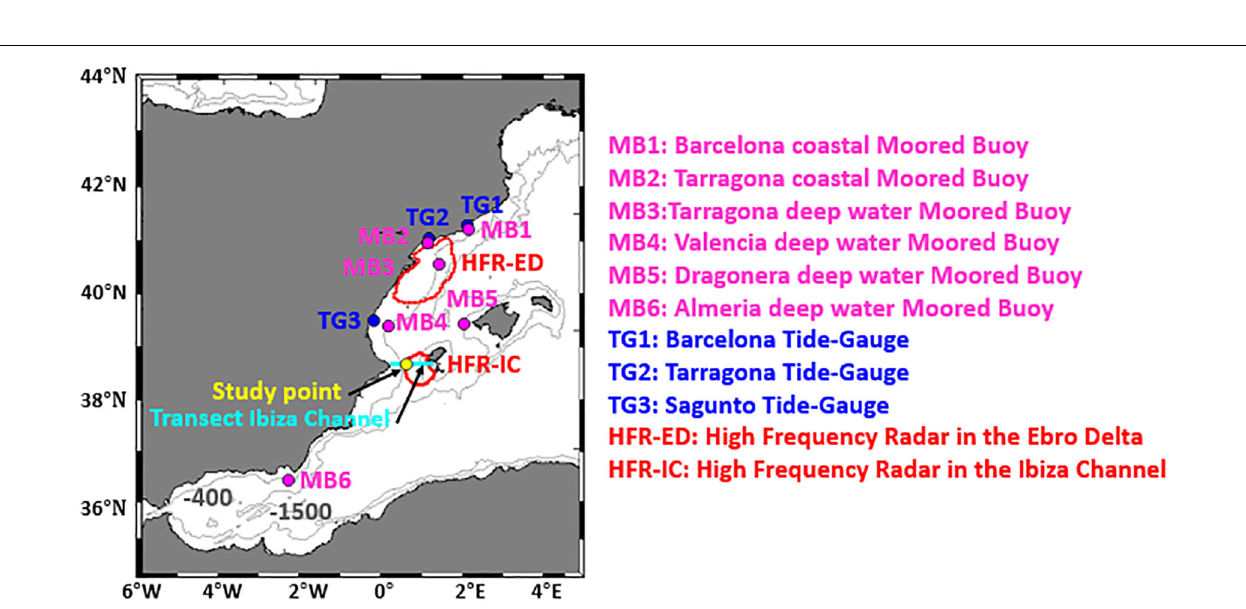
Frontiers in Marine Science |